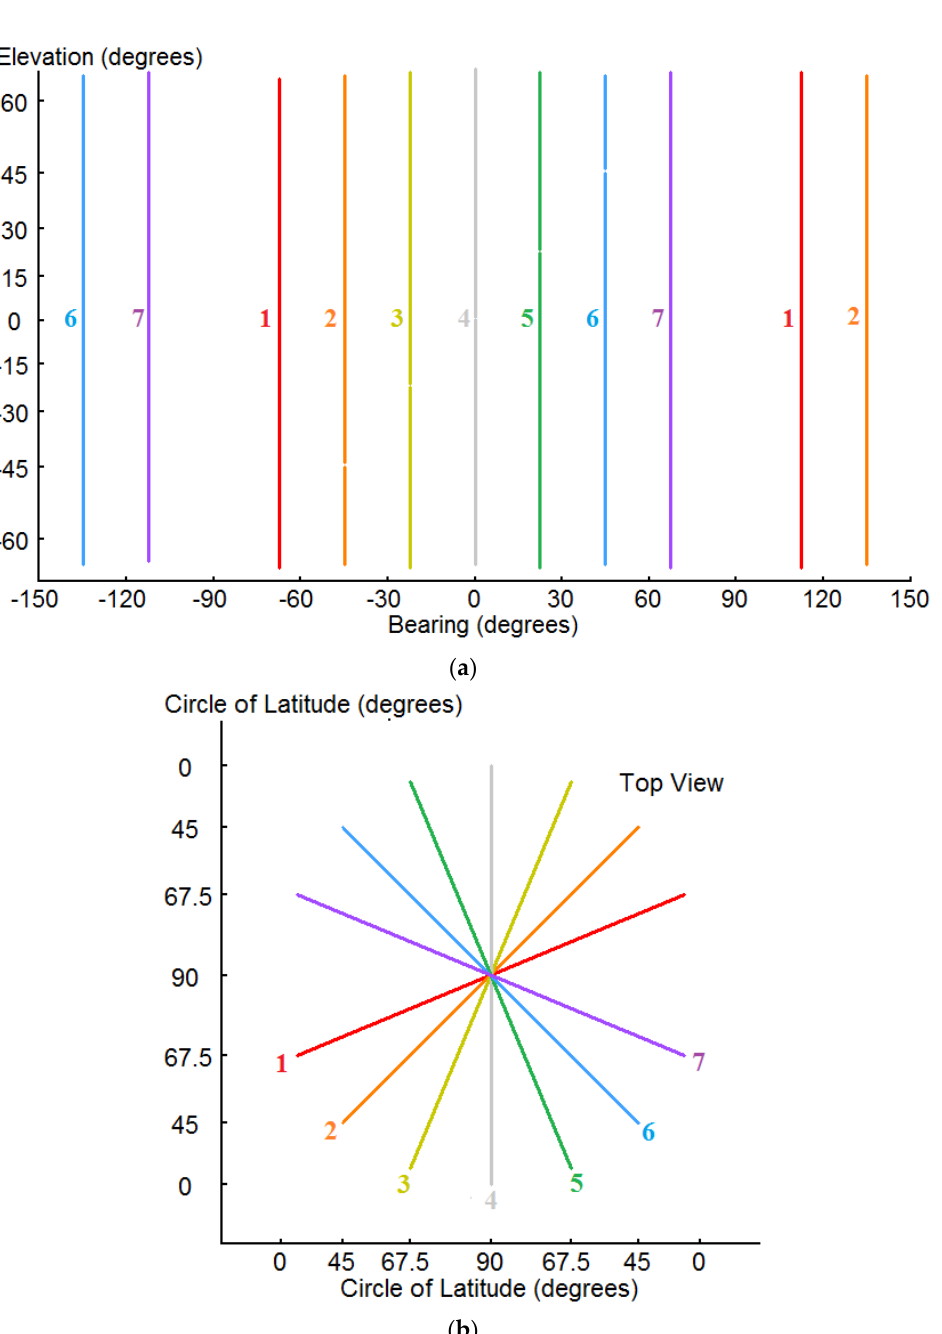
Figure 1. ( a ) Skeletonised synthetic ‐ aperture image of the field of audition in a Mercator projection. Lambda circles are shown for seven discrete bearings, in which the head faces as it turns (or yaws) from 67.5° to the left (port) (index 1; coloured red), through 22.5° increments, to 67.5° to the right (starboard) (index 7; coloured violet) with respect to the mean position (0°, index 4; coloured grey). ( b ) The same lambda circles presented in Figure 1a, but shown in a top view. If instead of considering the intersections of the lambda circles in two dimensions, the intersection of the median planes on which the circles lie is considered in three dimensions, the planes all intersect on the vertical line passing through the auditory centre. The source of sound is then no better disambiguated than to be somewhere on this polar axis. In forcing a solution, the mean position of all positions on the polar axis is the auditory